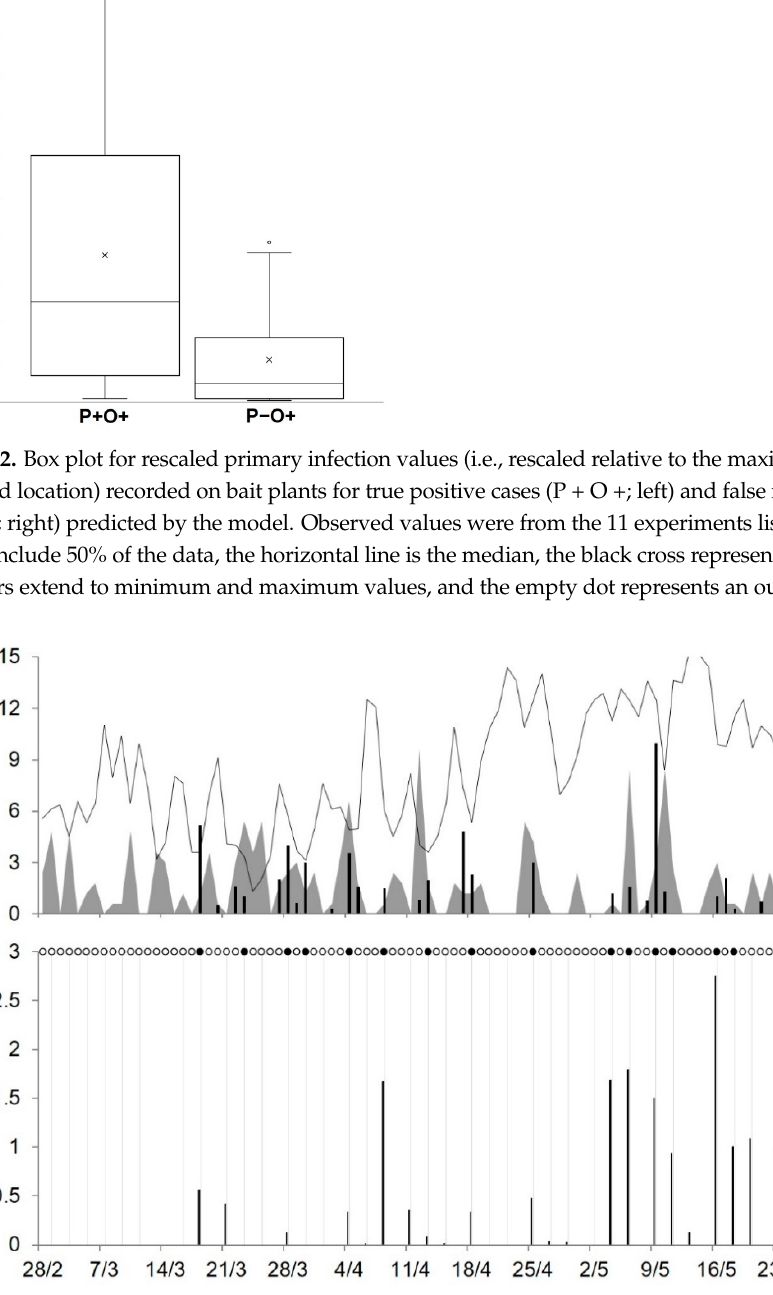
Figure 3. Predicted primary infections and observed primary Ascochyta blight lesions on bait plants (cv. Burpee) exposed to chickpea debris affected by A. rabiei at Washington State University’s Spillman Research Farm, US, in 2005. ( a ) Weather variables: air temperature (T, ◦ C, solid line), rainfall (Rain, mm, black bars), and leaf wetness duration (WD, hours, grey area). ( b ) Black bars represent the